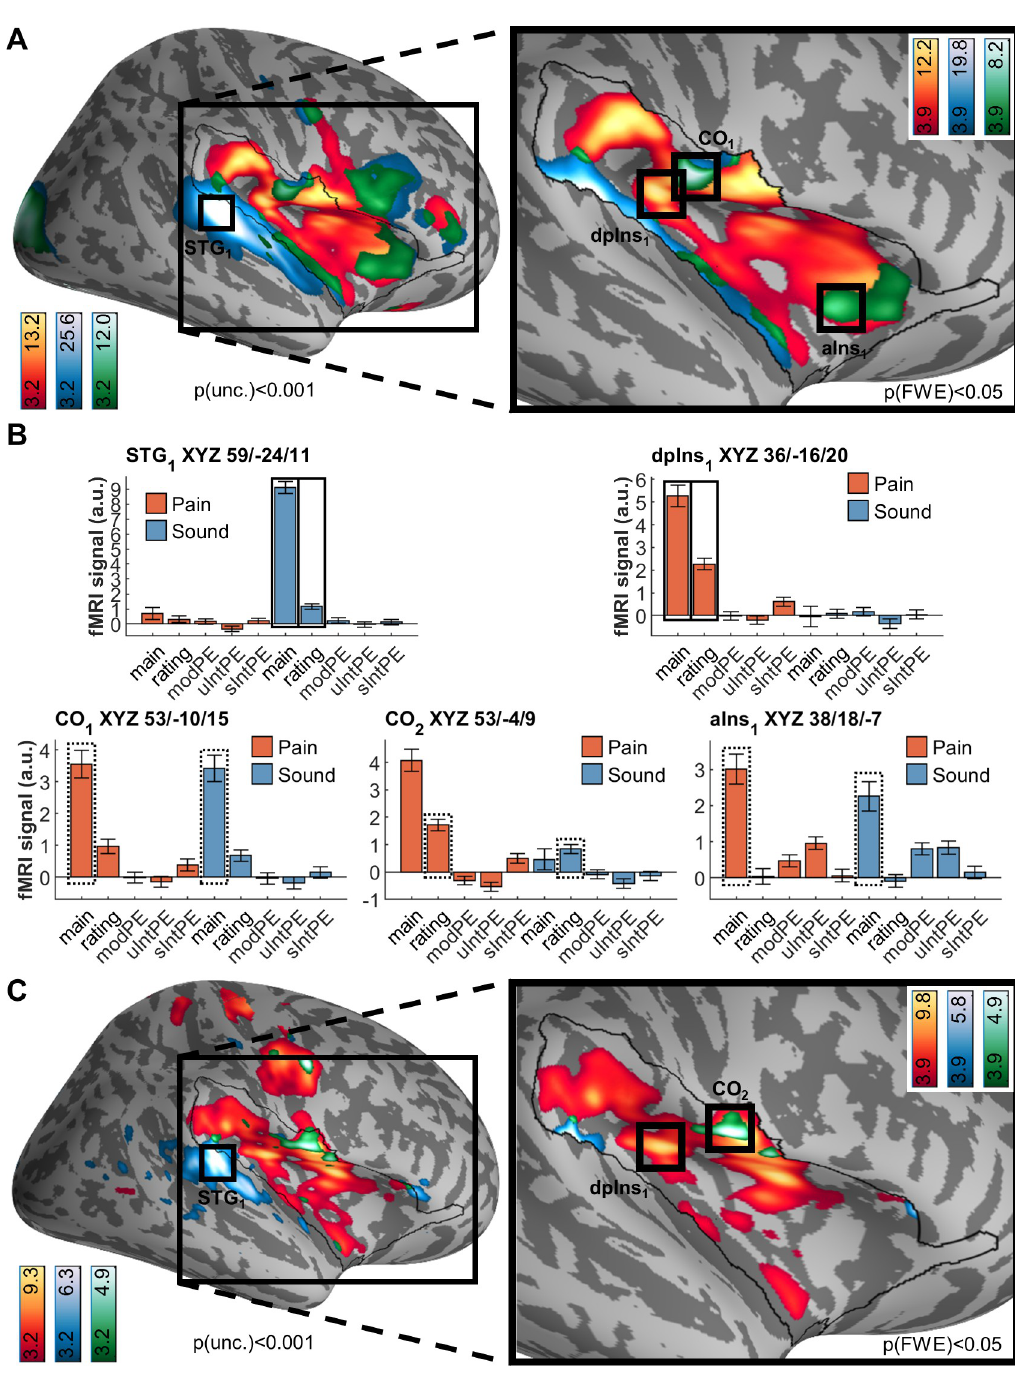
Fig 5. Brain activation following pain (red/yellow) and sound (blue), including overlaps as per conjunction analyses (green). Activations are overlaid on an average brain surface; for display purposes, activations in the whole brain lateral view are thresholded at p[uncorr.] < 0.001. The black line in the zoomed-in view delineates the region of interest and includes activations within the small volume FWE corrected at p[corr.] < 0.05. Peaks are shown for small volume only; bar plots show beta weights of BOLD activation obtained from a general linear model (see Materials and methods) from the respective peaks. See Supporting information for peak positions in whole brain (S4 and S6 Figs) and brain volume slices (S5 and S7 Figs). (A) Differential and shared activation following painful heat stimulation and loud sound stimulation. Peak activation following heat is located in (peri)insular areas contralateral to stimulation, namely the dorsal posterior insula (dpIns 1 ), and extending through the central and parietal opercula. Peak activation following sound is located in the superior temporal gyrus. Common